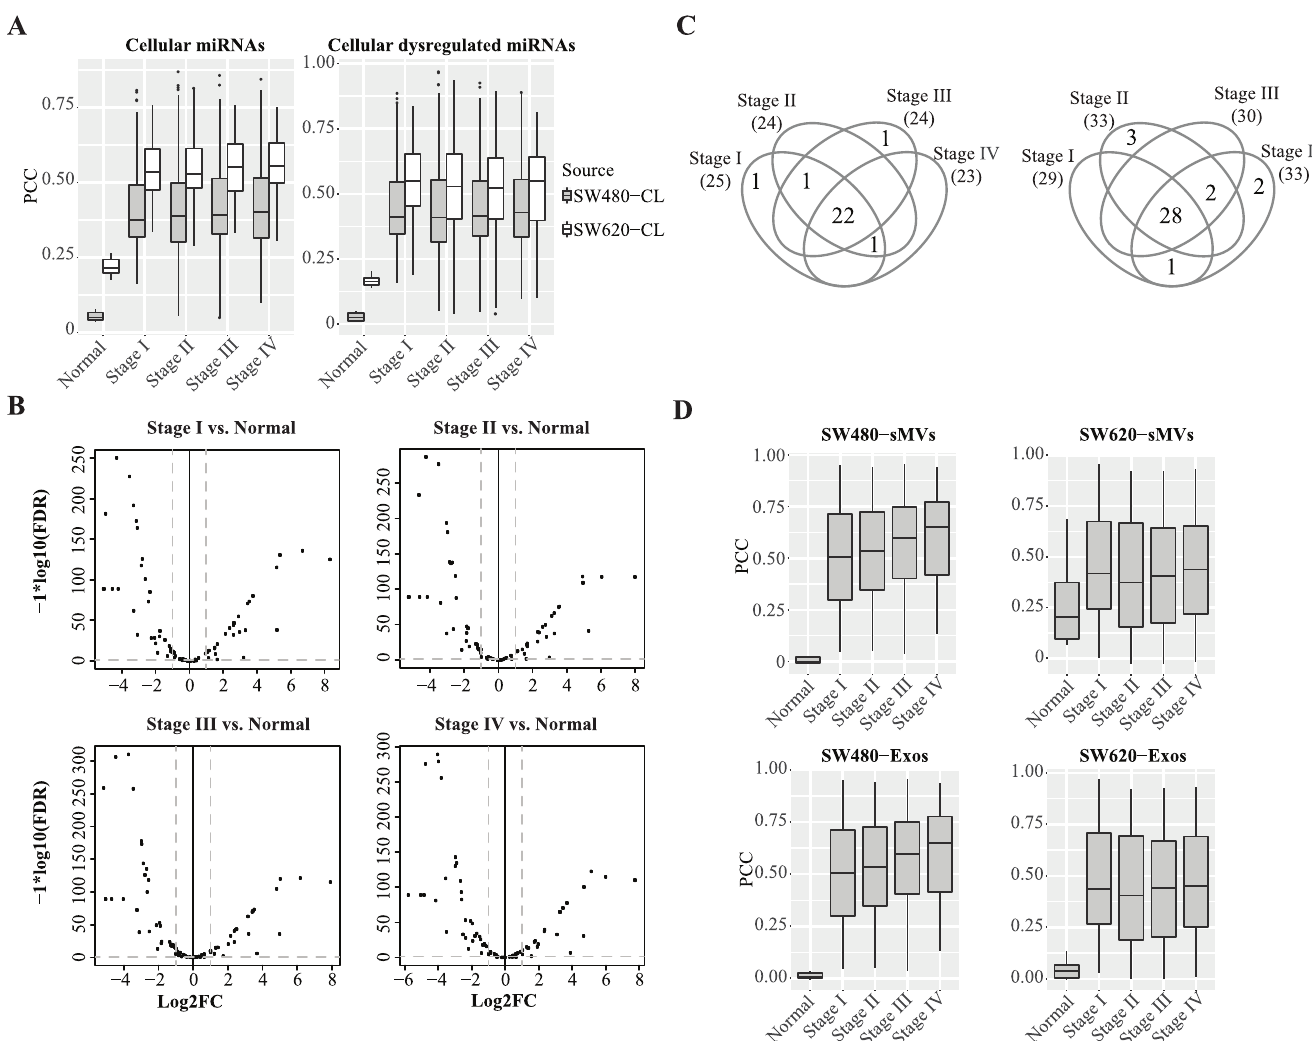
Fig 4. Correlation of miRNAs in SW480/SW620 cell lines and their secreted EVs with miRNAs expressed in non-tumoral colon tissues and CRC tumours. A , Pearson correlation coefficients of SW480/SW620 cellular miRNAs and dysregulated cellular miRNAs with miRNA expression profiles of normal colon tissue (11 samples) and 594 tumor samples from different pathological stages; tissue samples were obtained from TCGA. B , Volcano plot for comparing 97 EV-enriched miRNAs (from this study) in different CRC tumor stages with normal colon tissue; x-axis: log2FC, y-axis: -log10 (FDR). The vertical dash lines represent the cut-off levels of log2FCs < -1 (down-regulated miRNAs in tumours, relative to normal colon tissue) or > 1 (up-regulated miRNAs in tumours, relative to normal colon tissues), respectfully. The horizontal dash line shows the cut-off for FDR < 0.05. C , Venn diagrams of the number of up-regulated (left) /down-regulated (right) miRNAs identified in CRC tumours of different pathological stages. D , Pearson correlation coefficients of SW480/SW620-EV miRNA profiles with miRNA expression profile of different stage colon tumours and normal colon samples. https://doi.org/10.1371/journal.pone.0210003.g004 (Table 2). A salient finding of this study is that the mean PCC values between EV miRNA pro- files and normal colon tissue miRNA profiles are striking lower than the mean PCC values between cellular miRNA profiles and normal colon tissue miRNA profiles, thereby enhancing CRC tumour prediction accuracy (Fig 4D, Table 2).